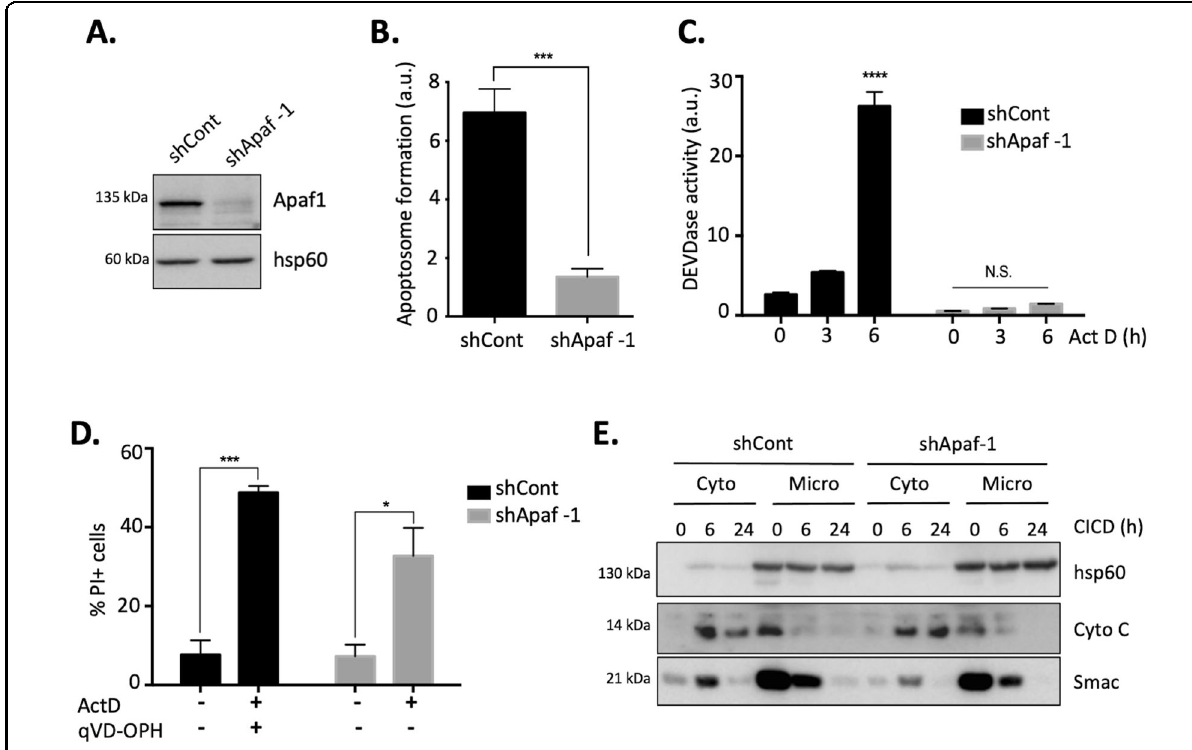
Fig. 1 Generation of a cell line model to identify CICD regulators. HeLa cells were stably transfected with either a non-targeting shRNA (shCont) or a shRNA targeting Apaf-1 (shApaf-1). A immunoblotting for Apaf-1 in whole cell lysates isolated from both cell types (hsp60 was used as a loading control), B protein extracts were isolated from HeLa shCont or shApaf-1 cells and apoptosome formation was measured in vitro upon addition of cytochrome c, C HeLa shCont or shApaf-1 cells were treated with Actinomycin D (1 µM, as an apoptosis induction) for the indicated times and DEVDase activity was measured. D HeLa shCont were treated for 3 days with Act D (1 µM, to induce apoptosis) or with Act D (1 µM) + qVD-OPH (20 µM) to induce CICD. HeLa shApaf-1 cells were treated for 3 days with Act D (1 µM). qVD-OPH was not added to HeLa shApaf-1 cells as those cells cannot activate caspases upon Act D treatment (see B and C ). Cell death was analyzed by fl ow cytometry using a Propidium Iodide (PI) staining. E HeLa shCont or shApaf-1 cells were treated with Actinomycin D + qVD-OPH (1 μ M or 20 μ M respectively) as a CICD stimulus for the indicated times. Isolation of cytosolic (cyto) and microsomal fractions (micro, which contains mitochondria in particular) was assessed by cell fractionation. MOMP, assessed by looking at the relocalization of Cytochrome c (Cyto C) and Smac from the mitochondria to the cytosol upon CICD treatment, was measured by immunoblotting. hsp60 was used as a control for the presence of mitochondria in the microsomal fraction. Data are expressed as mean ± s.d ( n = 3), immunoblots are representative of 3 or more individual experiments. * p < 0.05, ** p < 0.01, *** p < 0.001, **** p < 0.0001 according to a two-way ANOVA. N.S: non-signi fi